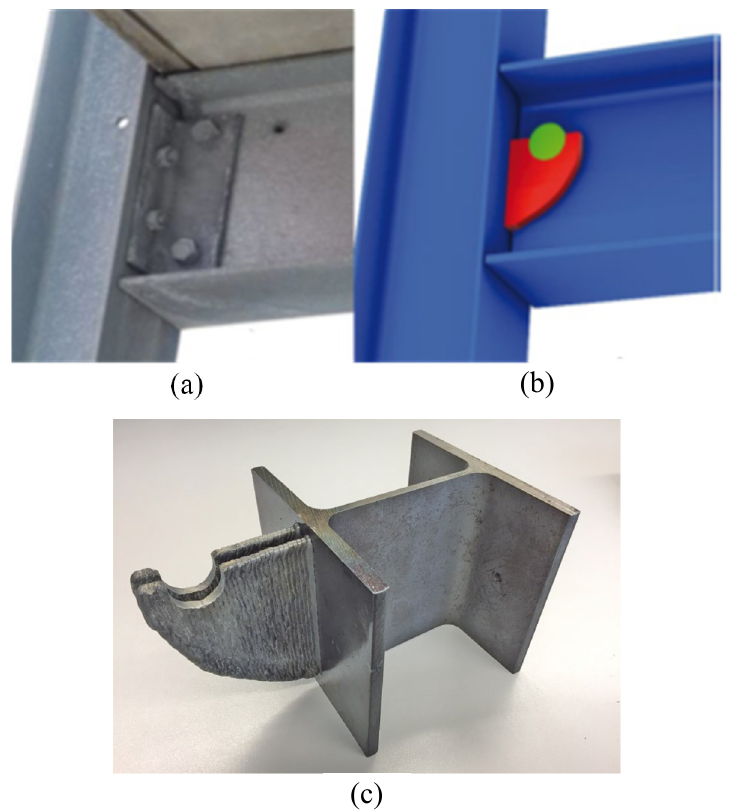
Figure 1. Use of WAAM in steel connections [21]; ( a ) Double angle connection, ( b ) Equivalent beam hook, and ( c ) 3D printed beam hook using WAAM.